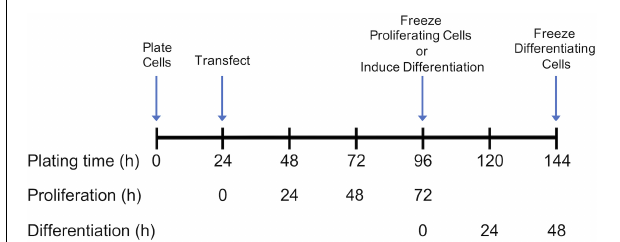
FIGURE 1 | Timeline for plating, transfection, proliferation, and differentiation of satellite cells. Following transfection or mock transfection, cells underwent proliferation for 72 h and were frozen for subsequent analysis. Alternatively, the medium was changed at 72 h to induce differentiation. Following 48 h of differentiation, cells were frozen for subsequent analysis. Experimental details are provided by Velleman et al.